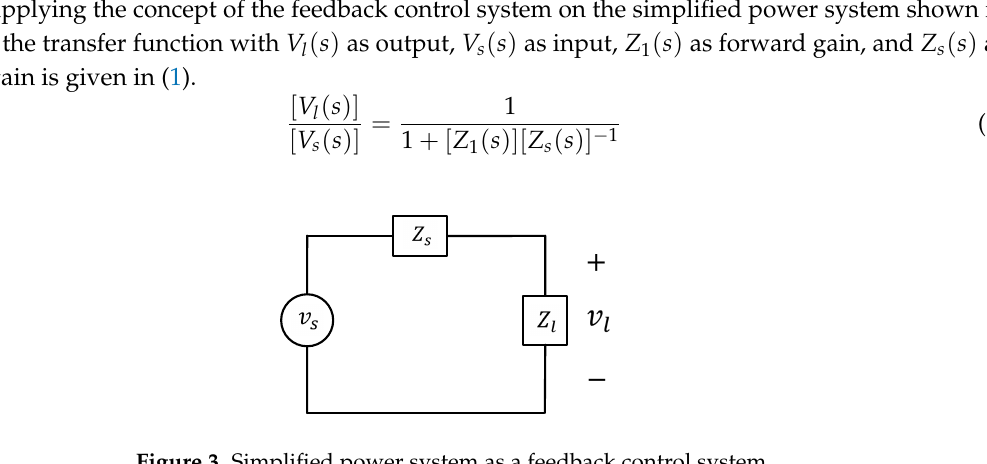
Figure 3. Simplified power system as a feedback control